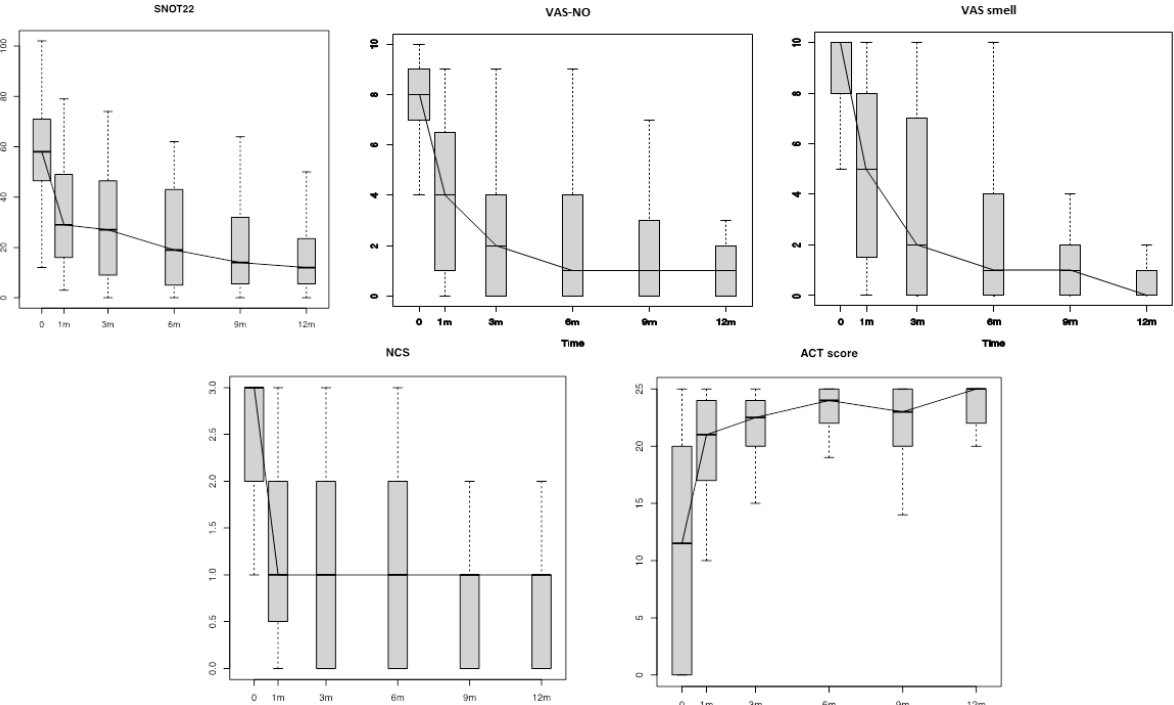
Figure 1. Patient-Reported Outcome measures (PROMs) changes during the study period.